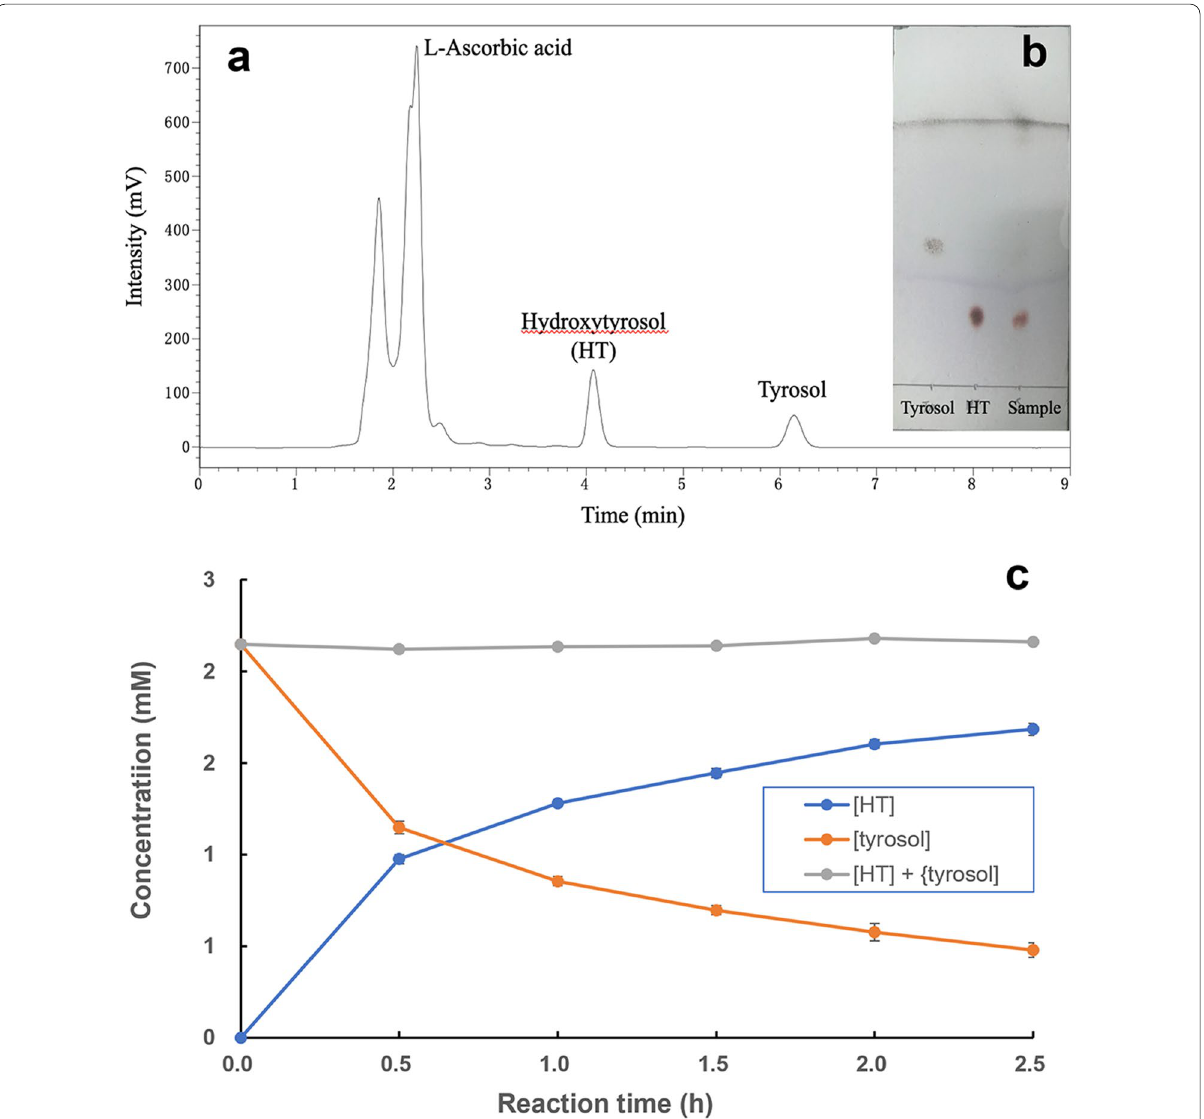
Fig. 5 Production of hydroxytyrosol (HT) from tyrosol catalyzed by tyrosinase@HKUST‑1 (I): identification of the substrate and product by means of HPLC ( a ) and TLC ( b ); time courses of the synthetic reaction ( c